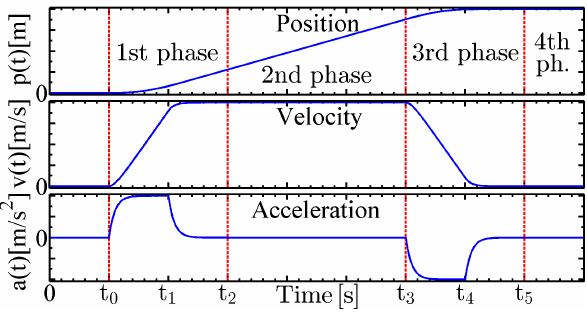
Figure 1: Shapes of the references synthesised by the RM concerning a single DoF